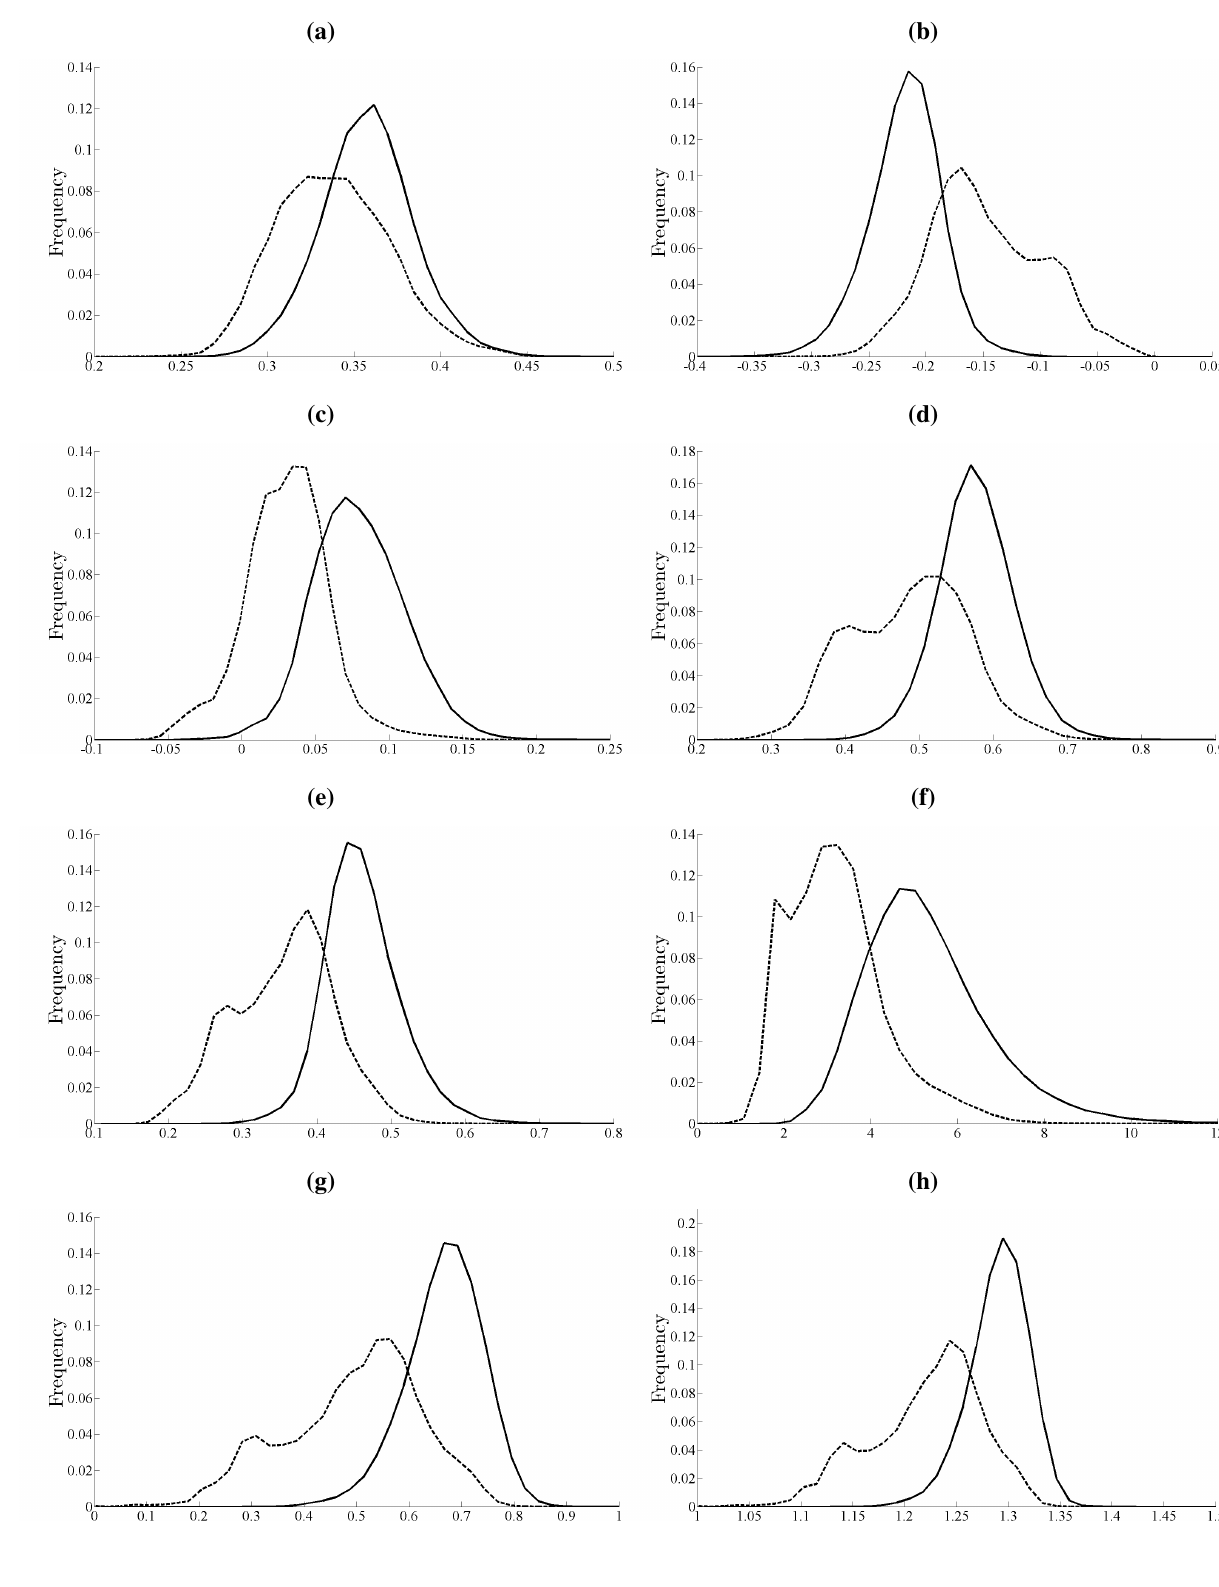
Figure 2. The histograms of candidate vegetation indices using QuickBird imagery. The histogram of oil palm tree is plotted with the solid line while background is plotted with the dashed line: ( a ) Excess green, ( b ) Excess red, ( c ) Excess blue, ( d ) Excess green minus excess red, ( e ) Normalized difference index, ( f ) Simple ratio, ( g ) Normalized difference vegetation index and ( h ) Transformed vegetation